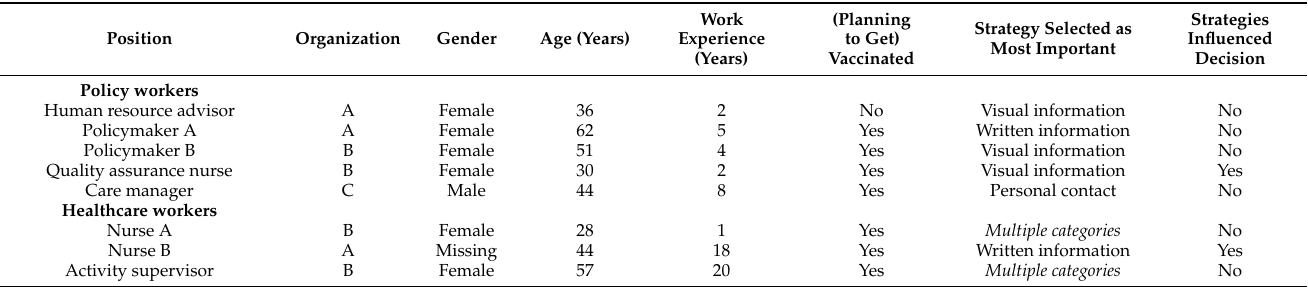
Table 1. Panel participants.